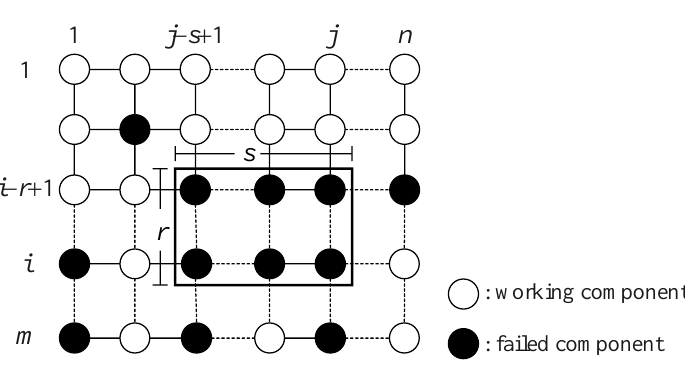
Fig. 1. Example of a connected-( r , s )-out-of-( m , n ):F lattice system